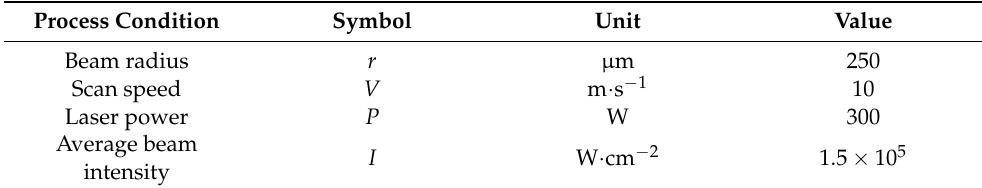
Figure 2. Scan path and overlap ratio for the laser beam, where black arrows indicate the scanning direction of the laser beam. The red circles and blue points in the red circles denote the edge and center of the laser beam, respectively. Table 1. Annealing process conditions used in the